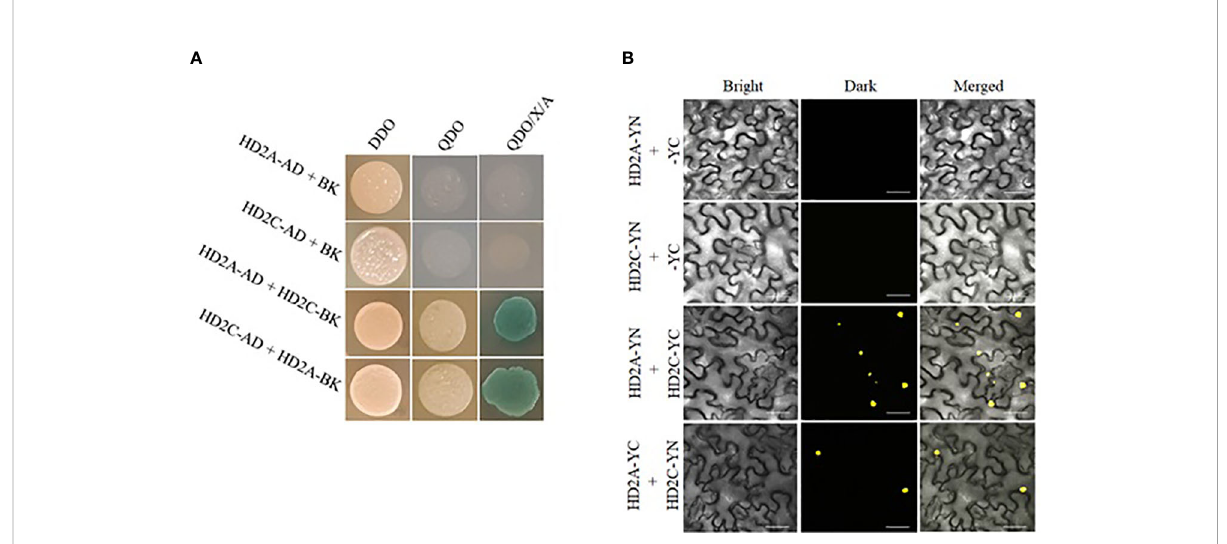
FIGURE 9 The HD2A and HD2C physically interact with each other. (A) Y2H assays showing interactions of HD2A and HD2C at the protein level. Transformed yeast cells were plated on minimal selective medium DDO (double dropout) and sub-cultured to QDO (quadruple dropout) and QDO/X/A (QDO supplemented with X-alpha galactosidase and Aureobasidin-A) medium to determine their ability to grow to identify protein interactions. Empty vector pGBKT7 was co-transformed with either HD2A-AD or HD2C-AD as a negative control. Blue colonies indicate protein-protein interaction. Three independent experiments were performed in this test. (B) BiFC (Bimolecular fl uorescence complementation) assays showing interactions of HD2A and HD2C in the plant host. The constructs HD2A-YN and HD2C-YC (or HD2A-YC and HD2C-YN) were co-in fi ltrated into leaf epidermal cells of Nicotiana benthamiana via for transient expression. YFP (Yellow Fluorescent Protein) signal was detected after 48-72 hours of in fi ltration. Empty vector pEarleyGate202-YC was co-transformed with either HD2A-YN or HD2C-YN as a negative control. Three independent experiments were performed in this test. (scale bar 50